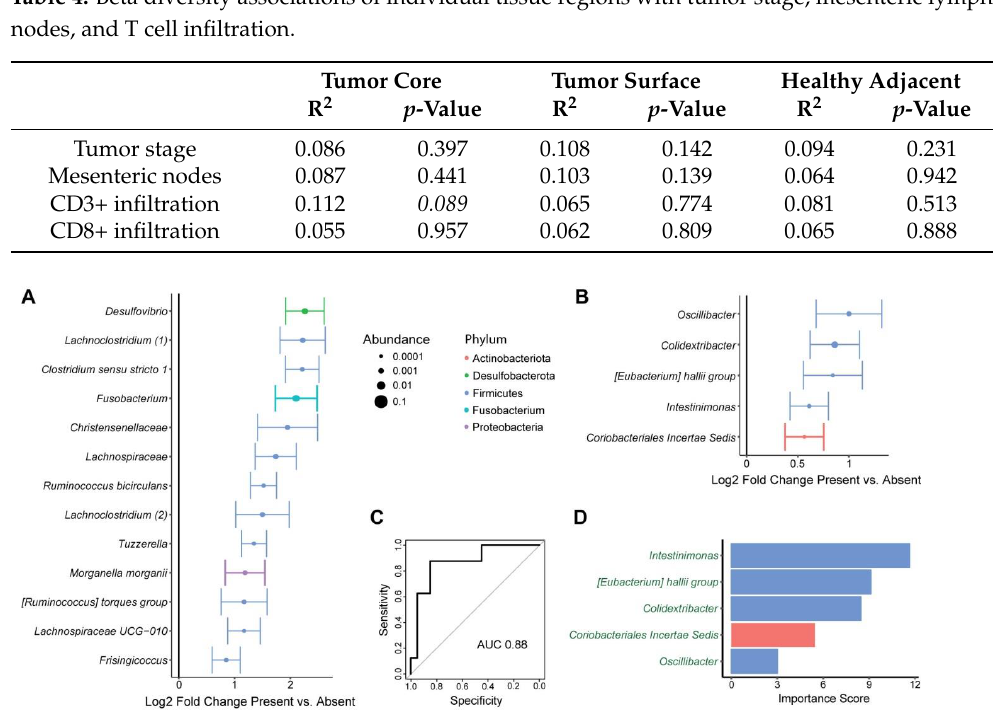
Table 4. Beta diversity associations of individual tissue regions with tumor stage, mesenteric lymph nodes, and T cell infiltration.